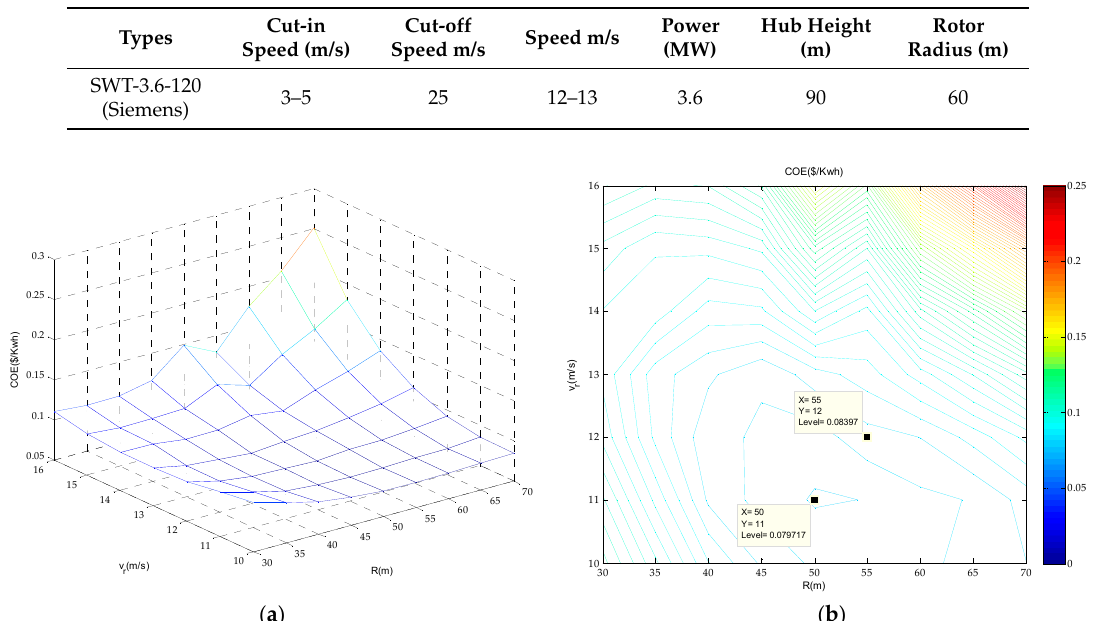
Figure 4. The relationship between the speed, rotor radius and COE: ( a ) 3D graphic and ( b ) contour map.